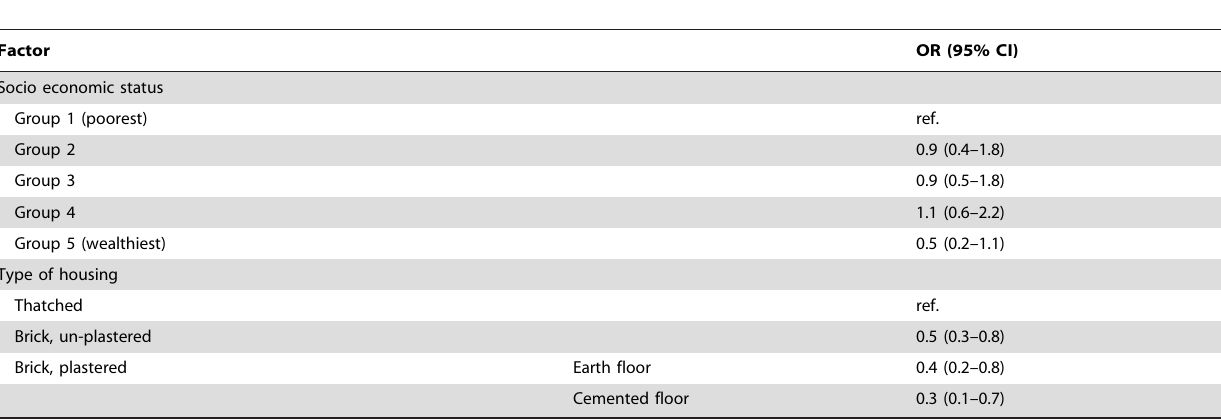
Table 5. Odds of presence of three stages of female Phlebotomus argentipes in the same household at the same time as a function of socio economic status and type of housing (multivariate model with village as random